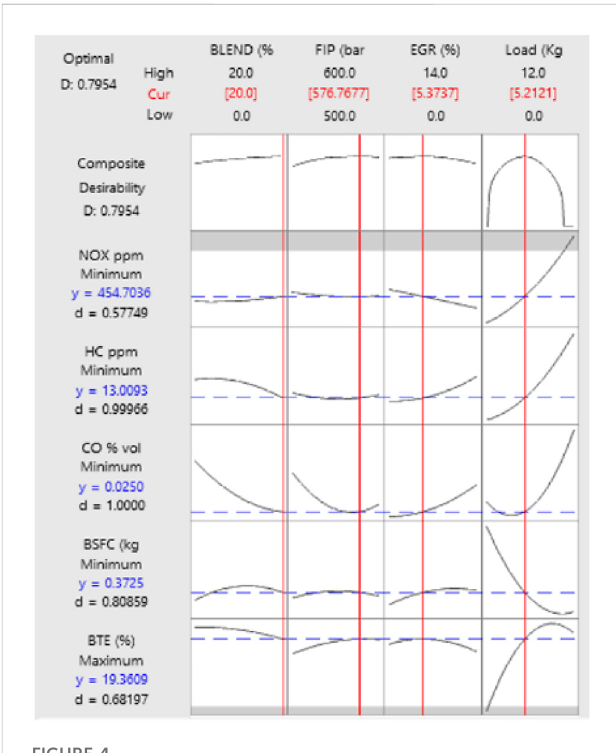
FIGURE 4 Numerical optimization ramp view for input factors and output